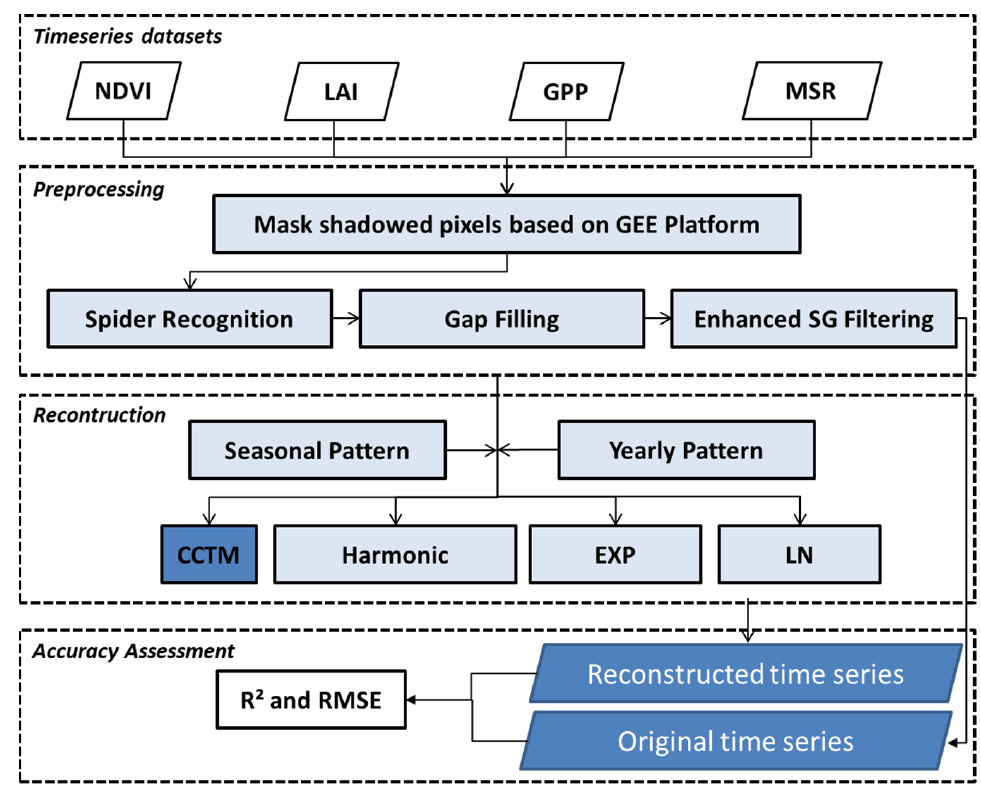
Figure 1. Flowchart of time series